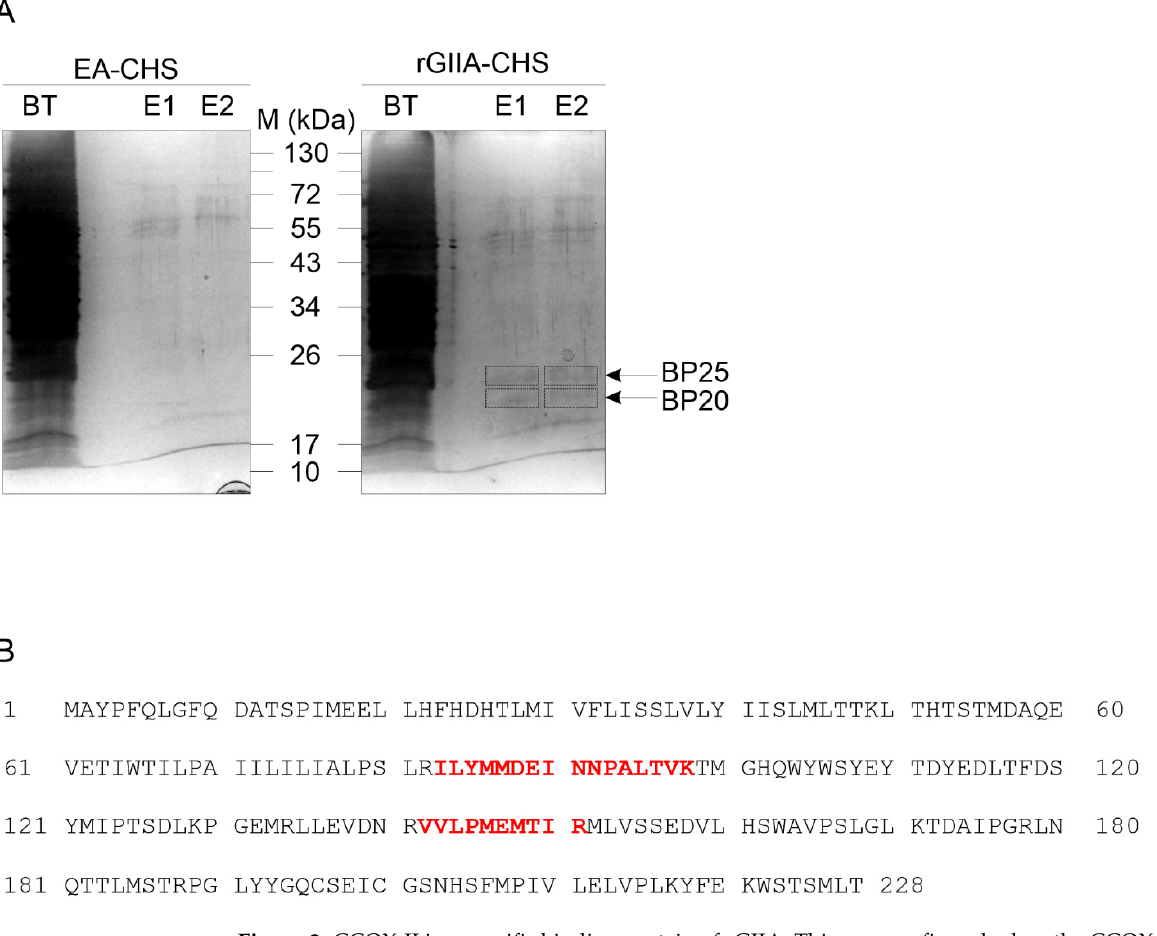
Figure 2. CCOX-II is a specific binding protein of rGIIA. This was confirmed when the CCOX-II was identified in the bound fraction of mitochondrial extract using the rGIIA-affinity media. ( A ) Porcine cerebral cortex P2d membranes were extracted with a detergent and the extract was chromatographed on an rGIIA-affinity column (rGIIA-CHS) and on a control column (EA-CHS). Proteins were eluted by lowering the pH from 7.4 to 5. The collected, unbound (BT) and bound fractions (E1 and E2) were analyzed with SDS-PAGE and the proteins were visualized via silver staining. Black boxes indicate the positions of excised bands. ( B ) The bands BP25 and BP20 were excised, and the proteins were reduced, alkylated and subjected to in-gel trypsin digestion. The resulting peptides were extracted from the gel and were analyzed by LC-MS/MS. Two tryptic peptides (red) from BP25 were identified as parts of the CCOX subunit II. No peptides could be identified in